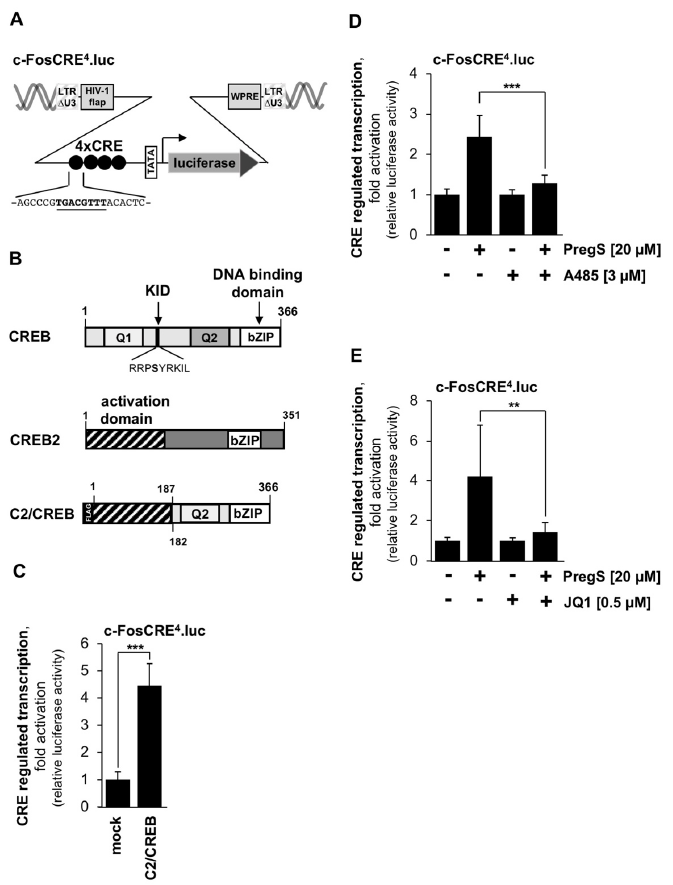
Figure 6. Pharmacological inhibition of CBP/p300 and BET bromodomain proteins attenuates TRPM3-induced activation of CREB. ( A ) Provirus containing the c-FosCRE 4 .luc gene. The